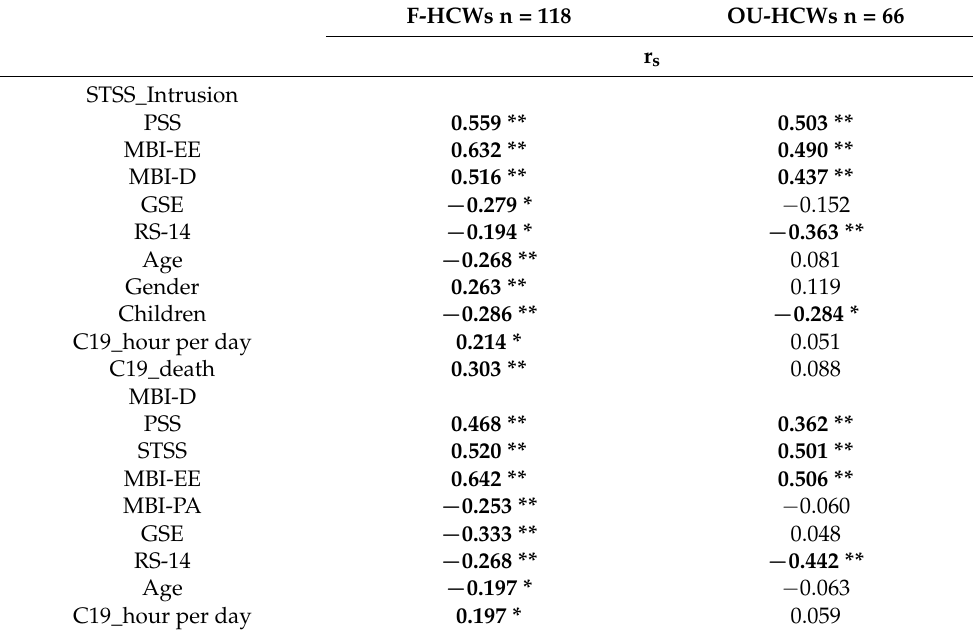
Abbreviations: same abbreviations as Table 4. Bold data indicate correlations that are significant. * p < 0.05; ** p <